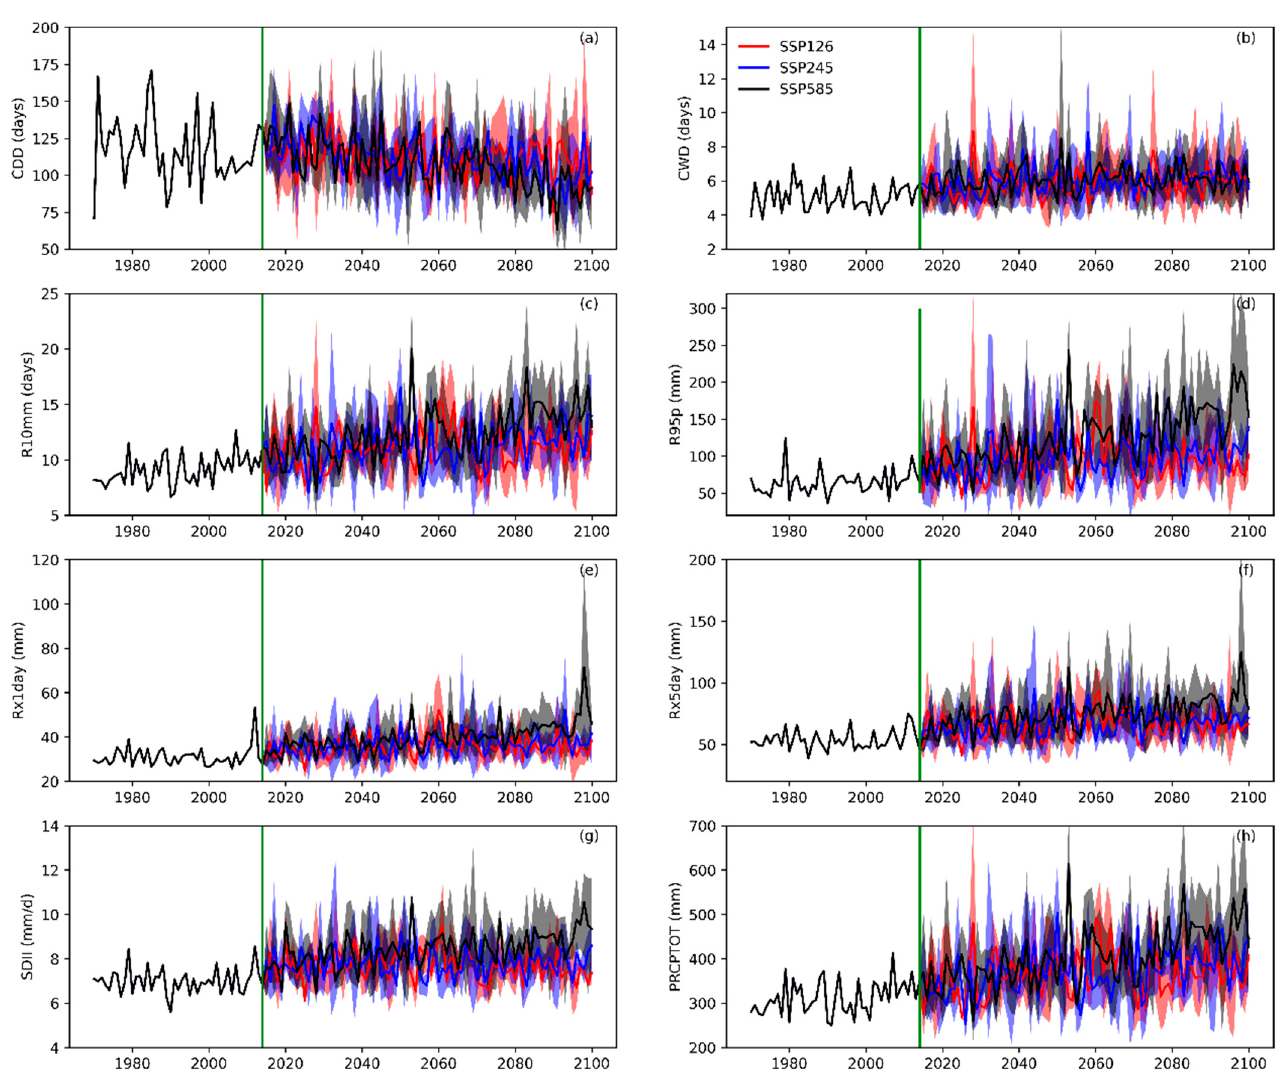
Figure 14. The inter-annual changes of eight extreme precipitation indices in the Qilian Mountains from 1970 to 2100. In the figure, ( a – h ) is respectively CDD, CWD, R10mm, R95p, Rx1day, Rx5day, SDII, and PRCPTOT. The green line in the figure (representing 2014) is the dividing line between the historical period and the future.